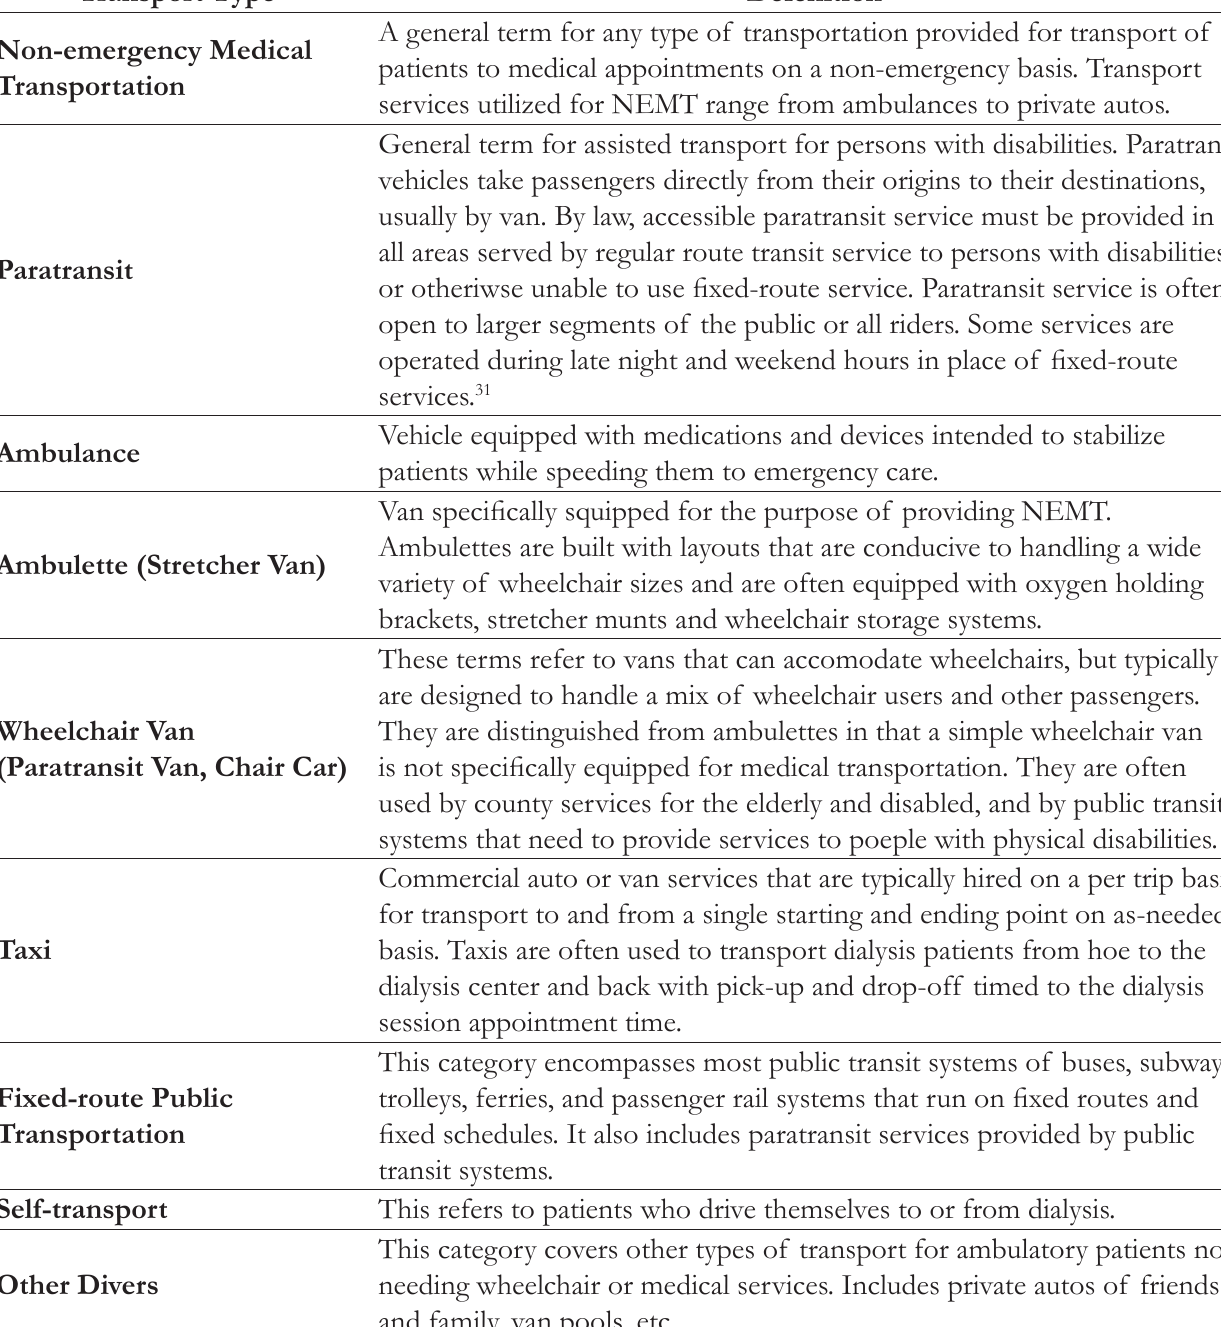
Table 1. Definitions for Transport Service Categories Used in the Model Transport